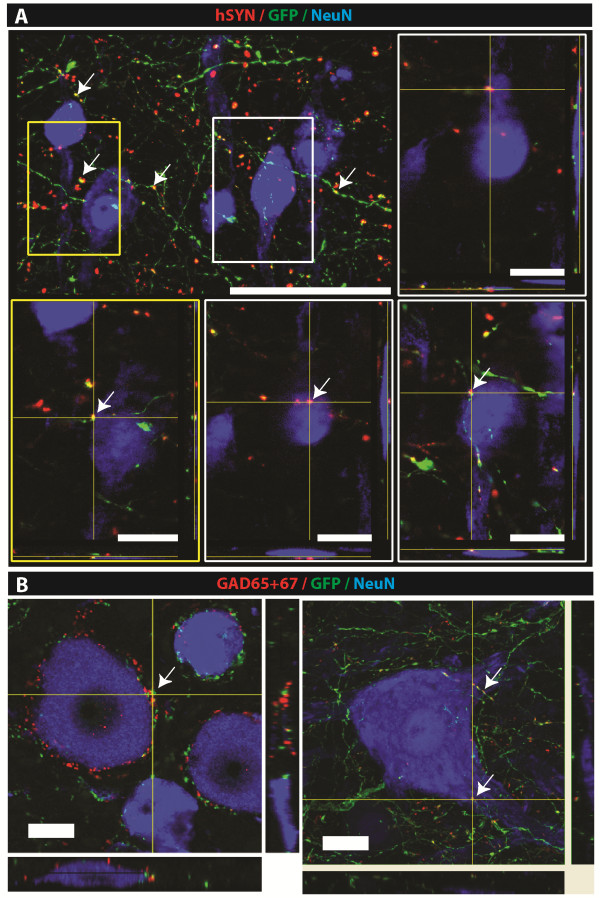
Development of putative GABA-ergic synaptic contact between HSSC and the host neurons. A: Confocal analysis of hSYN/GFP/NeuN-stained sections shows numerous hSYN punctata associated with GFP+ processes derived from grafted cells. Some of the hSYN/GFP+ terminals were found to be in the vicinity of the host interneurons or α-motoneurons (A; inserts; white arrows). B: Triple staining with GAD65/67/GFP/NeuN antibody showed numerous double-stained GAD65/67/GFP+ terminals residing on or in the close vicinity of lumbar α-motoneurons (white arrows). (Scale Bars: A: 150 μm (inserts: 30 μm); B: 20 μm). HSSC, human fetal spinal cord-derived neural stem cells.